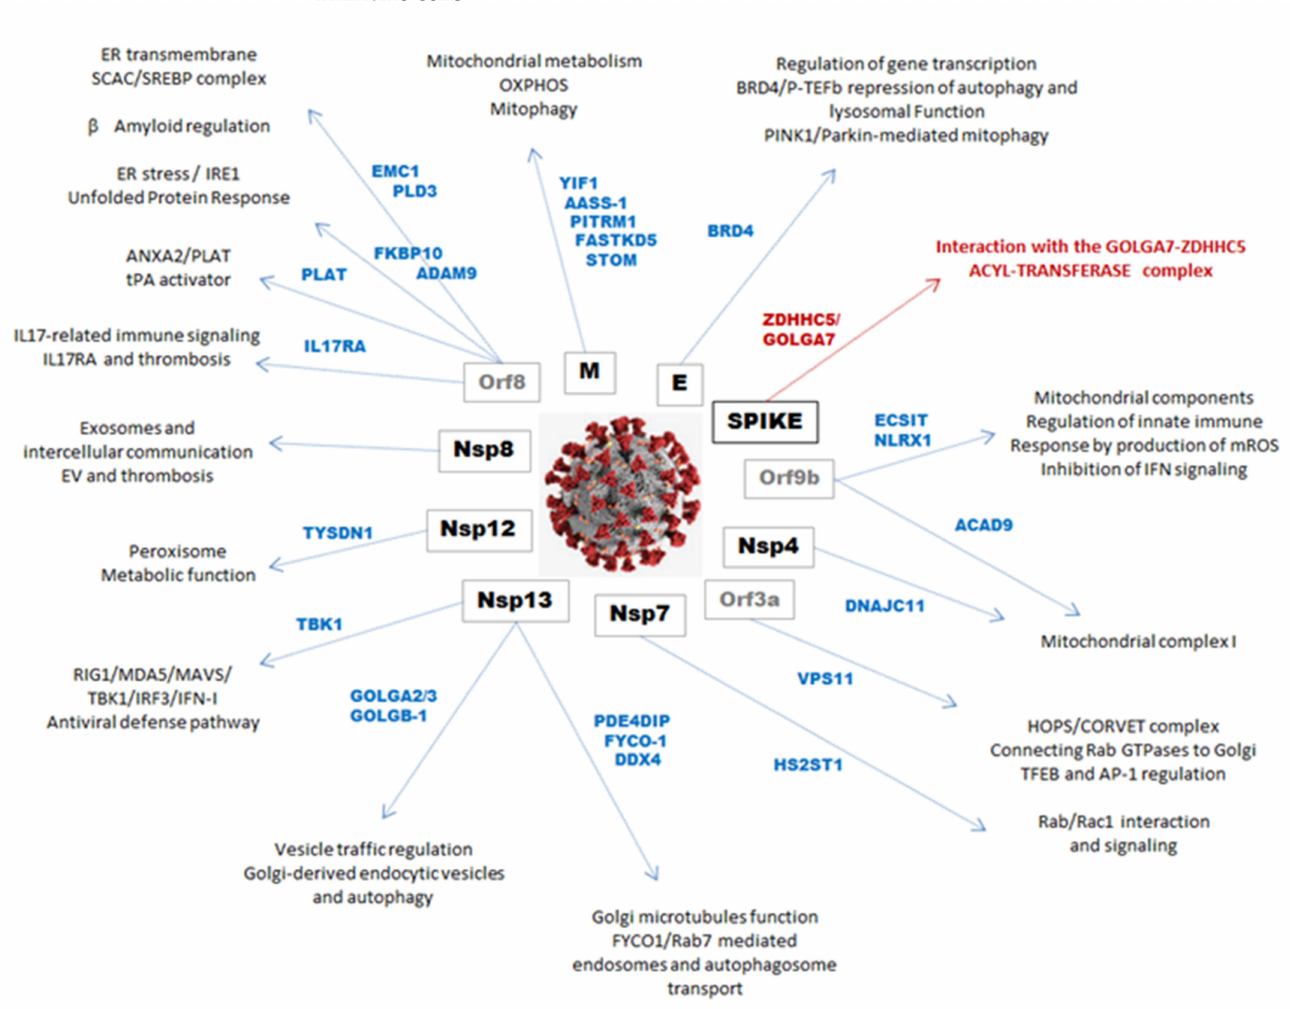
Figure 5. Schematic representation of the interactions of the proteins of the SARS-CoV2 virus with the proteins encoded by the mutated genes in the familial forms of sarcoidosis, with a summary of the intracellular functions concerned. Abbreviations: Nsp, non-structural viral proteins; Orf, open reading frame. The gene acronym descriptions are in the